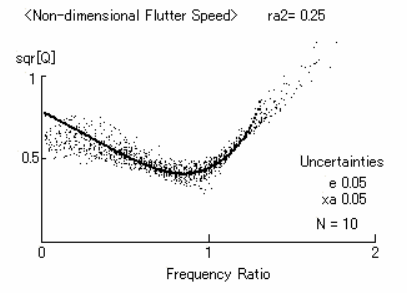
Fig 5. Boundary with uncertainty of 5% in both parameters